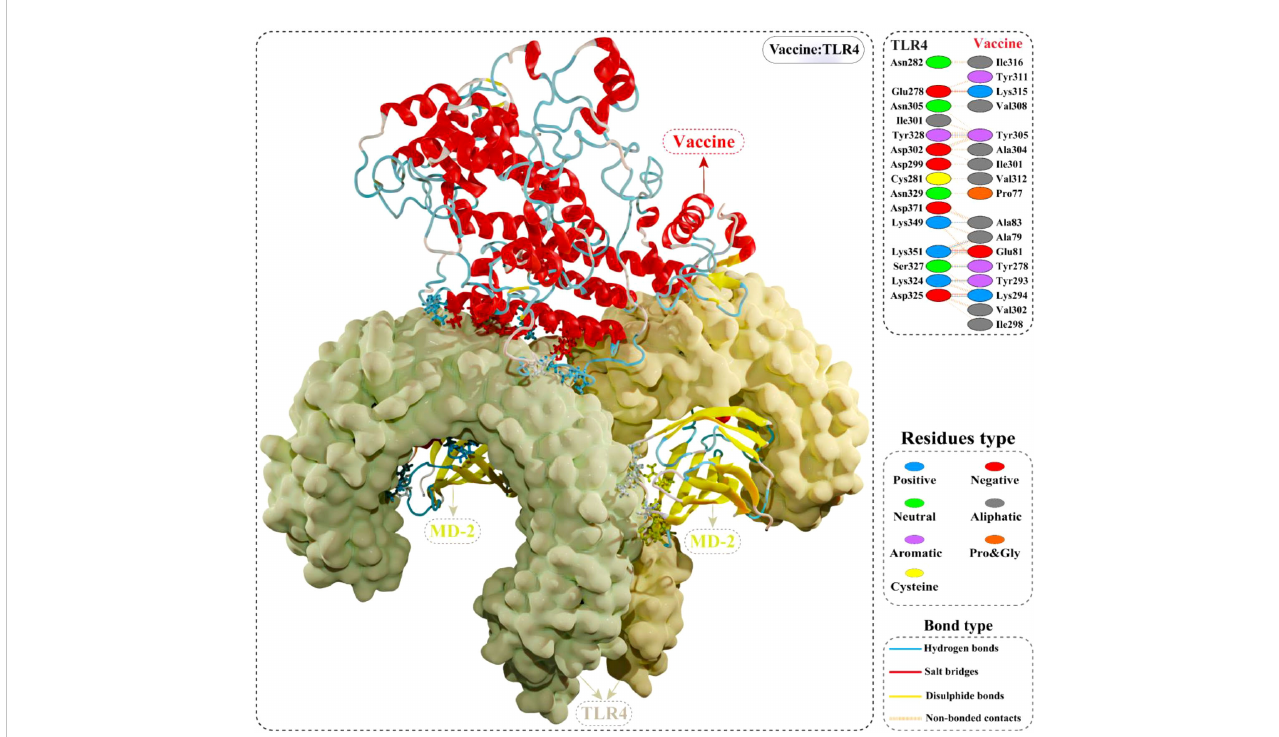
FIGURE 7 Optimal binding mode of the modelled vaccine (red) with TLR4 dimer (light yellow) obtained via molecular docking. Atomic interactions between the putative vaccine – TLR4 interface are shown at the top right. Hydrogen bonds are depicted in blue lines. The residue type is shown with a distinctive